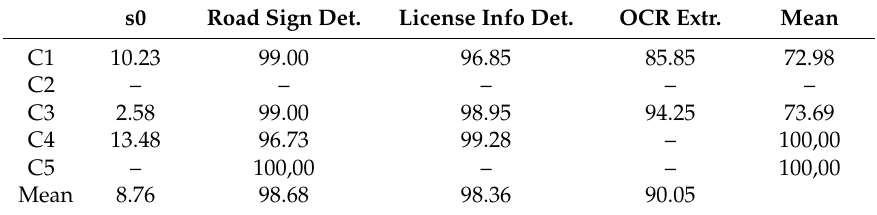
Table 3. Results for the Probabilistic Score on the 2976 × 3968 image pixel resolution. s0 Road Sign Det. License Info